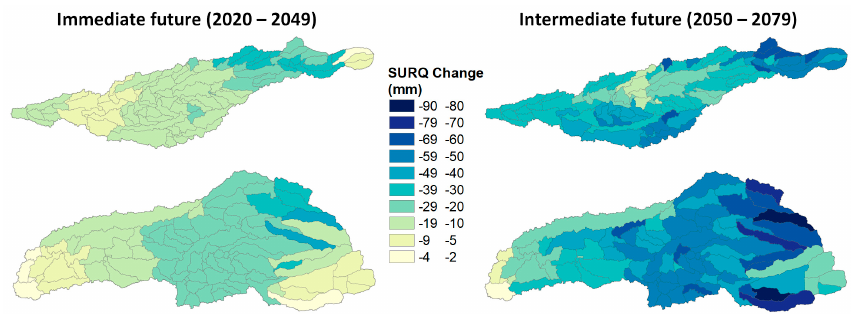
Figure 8. Changes in the yearly average surface runoff (SURQ) at the sub-basin scale, using RegCM4-MPI-ESM-MR, scenario RCP8.5.